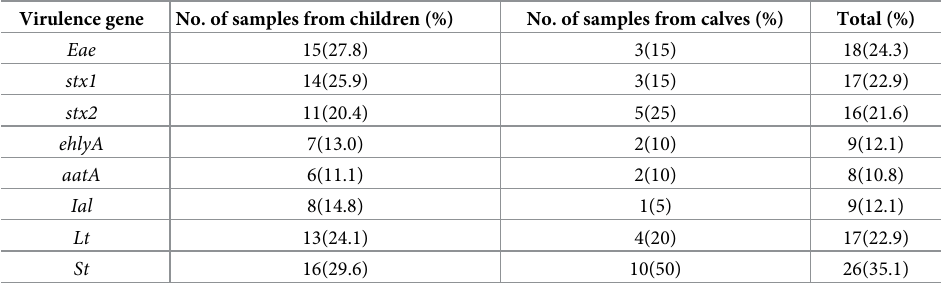
eae , attaching effacing gene; stx1 , Shiga-like toxin I gene; stx2 , Shiga-like toxin II gene; ehlyA , E . coli hemolysin gene; bfpA , bundle forming pili gene; aatA, aggregative adherence gene; ial , invasive gene; lt , Heat liable toxin gene; st ,